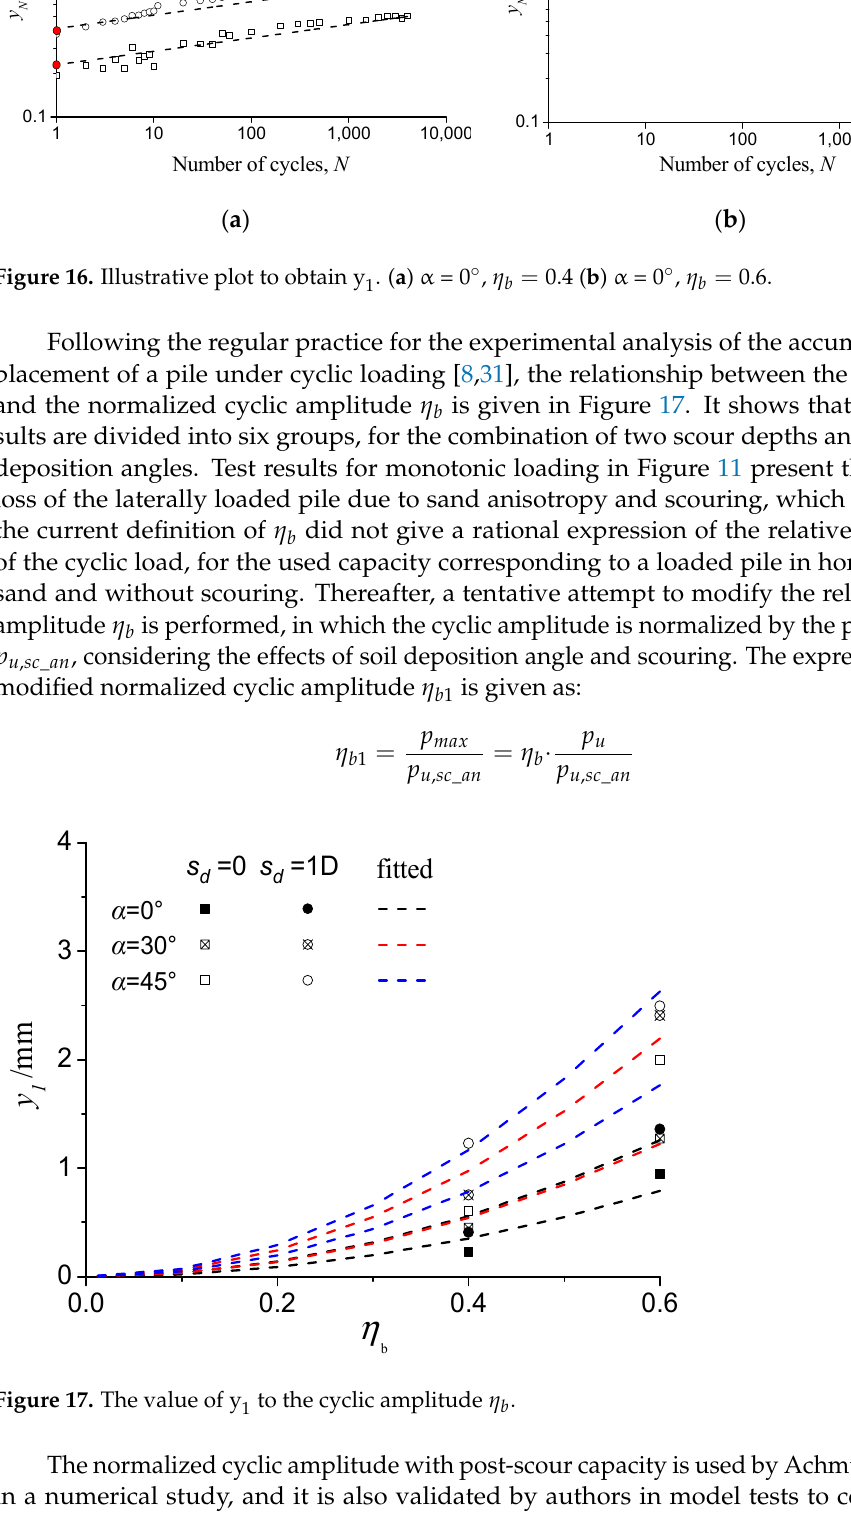
Figure 16. Illustrative plot to obtain y (cid:2869) . ( a ) α = 0°,